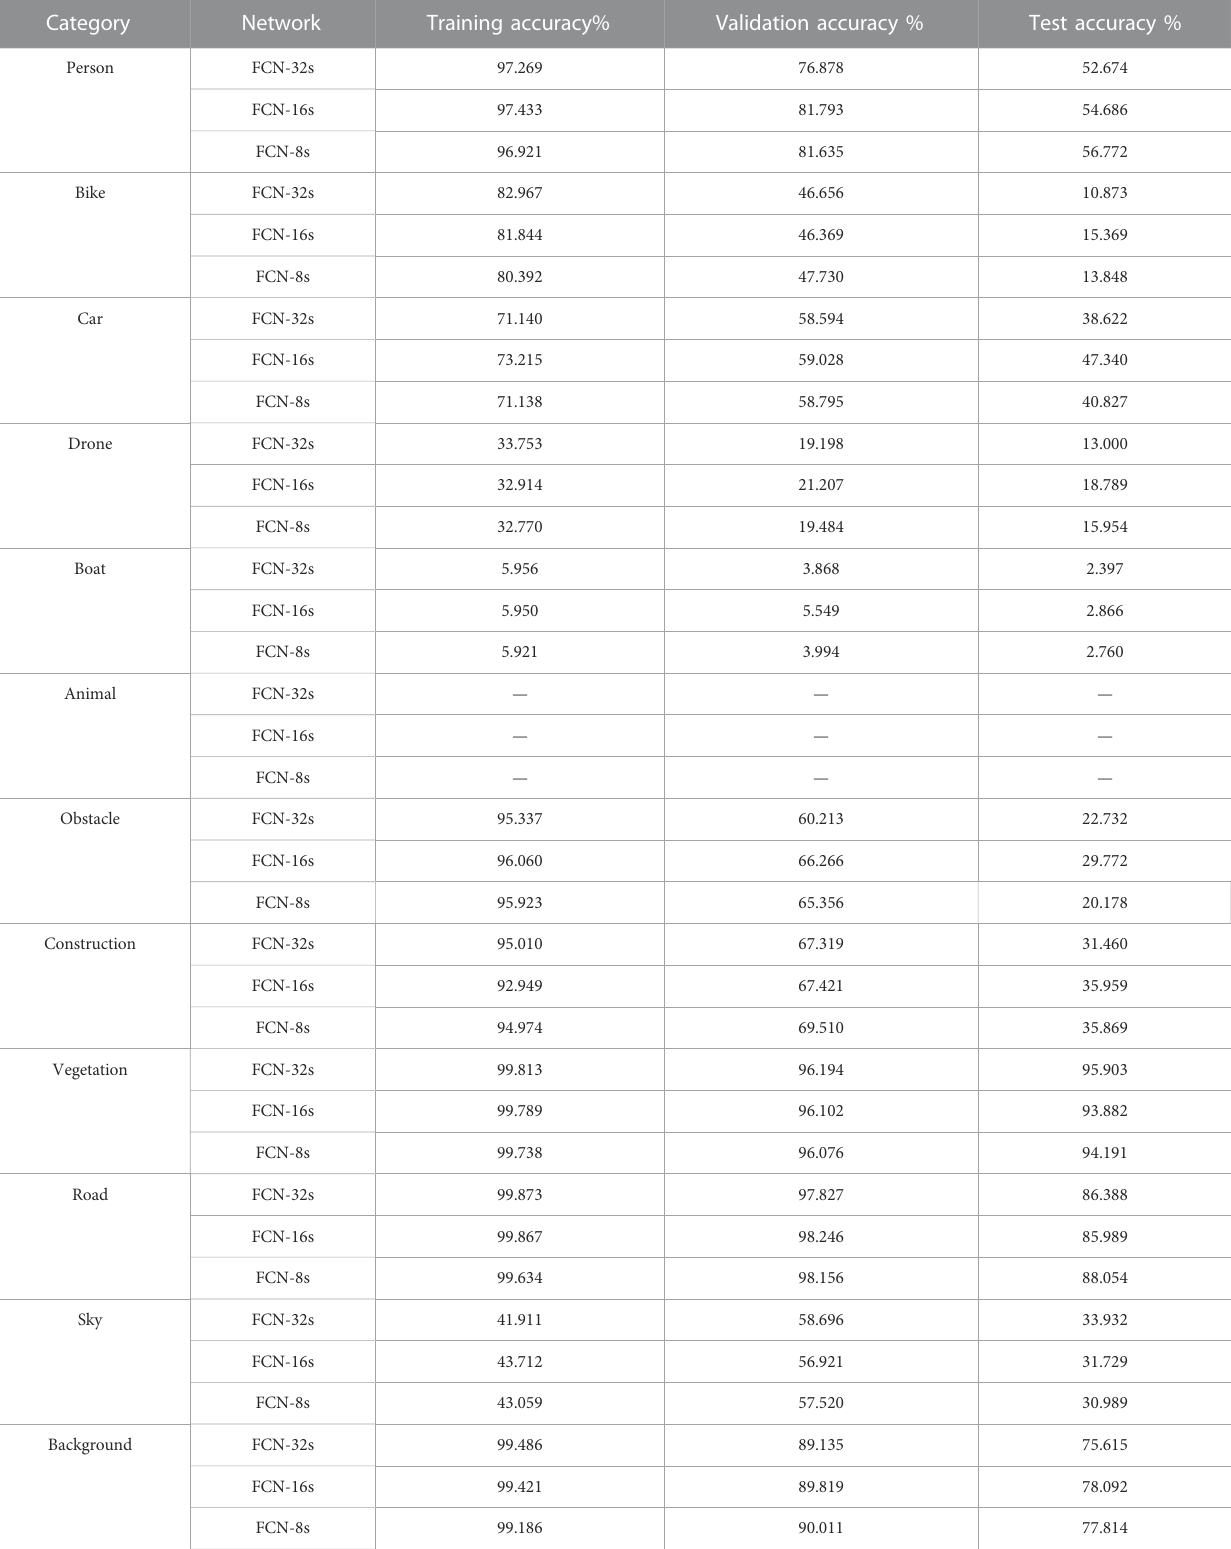
TABLE 3 The accuracy evaluation indicators for each category in the test